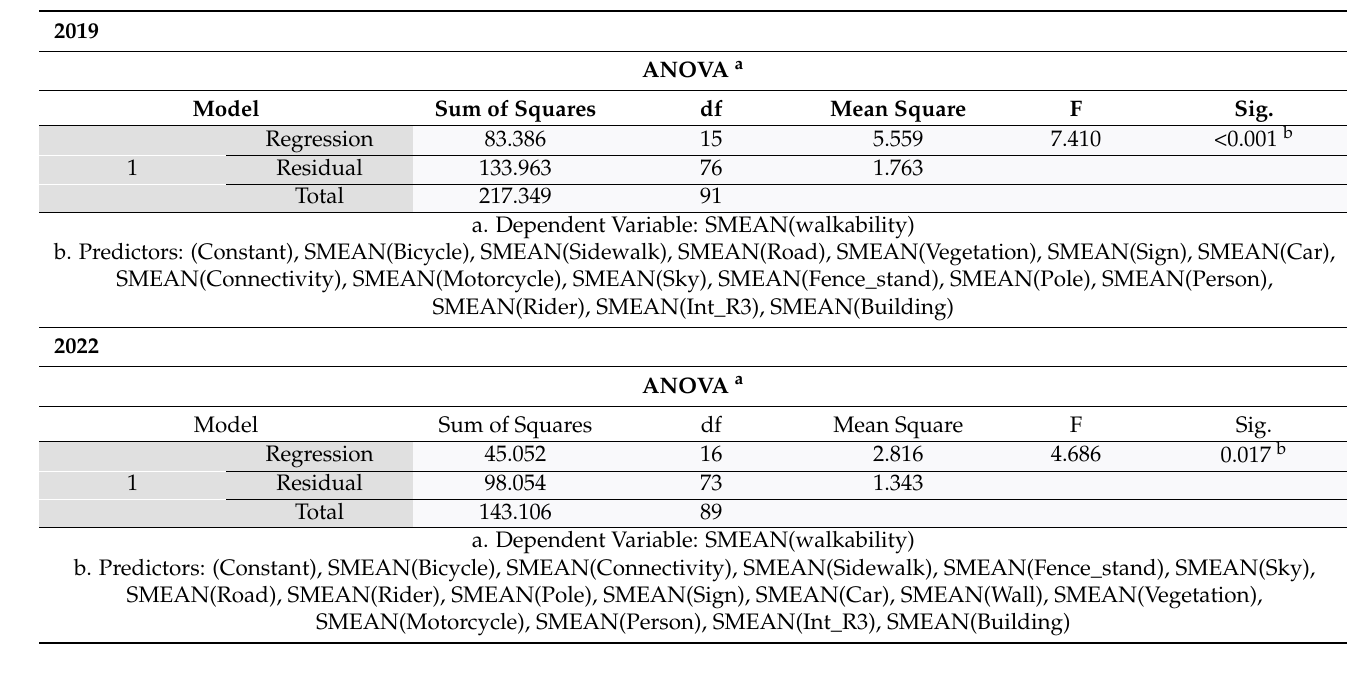
Table 5. Analysis of variance